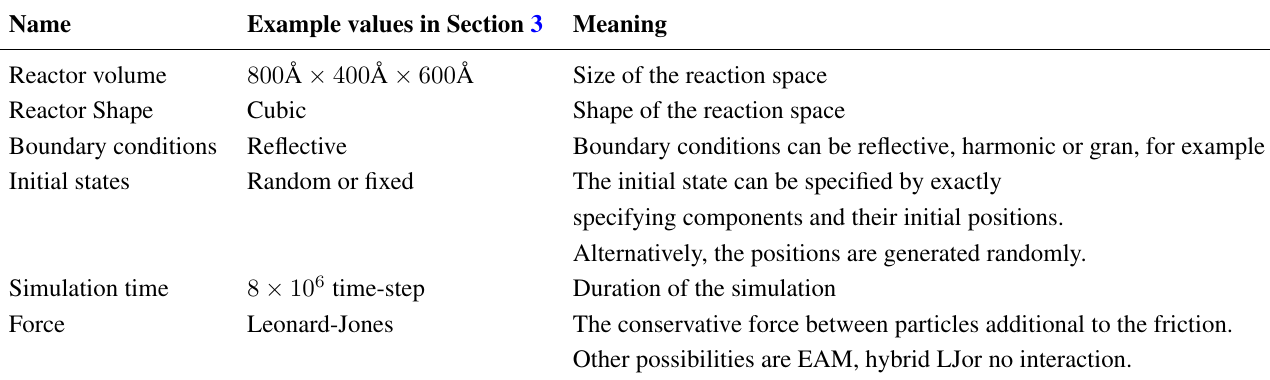
Table 3. Main simulation